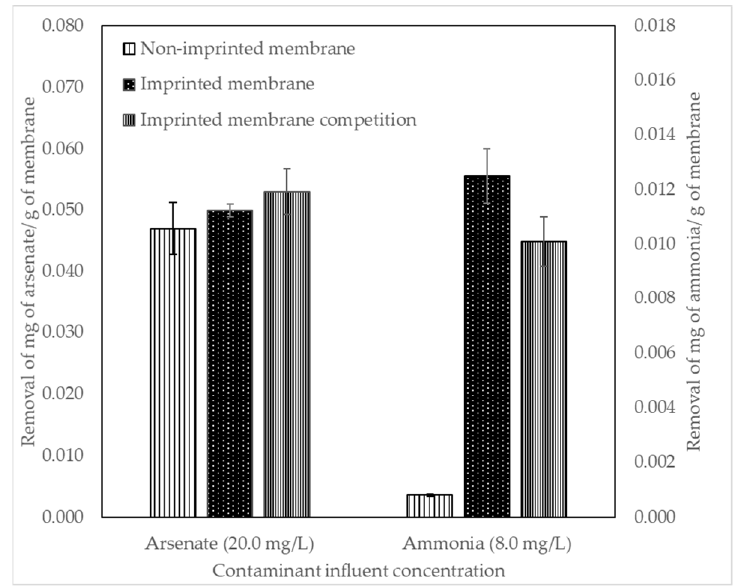
Figure 8. Arsenate and ammonia removal with non-imprinted and imprinted membranes and their respective competitions. The arsenate-imprinted membrane removes more arsenate in competition filtration. The ammonia-imprinted membrane removes more ammonia than the non-imprinted membrane, but it is not highly selective to